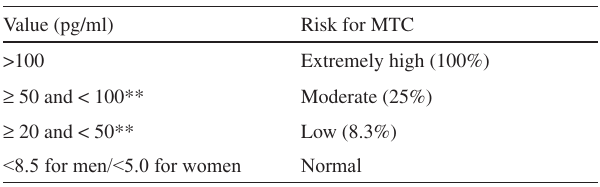
Table 2 - Calcitonin values and risk for medullary